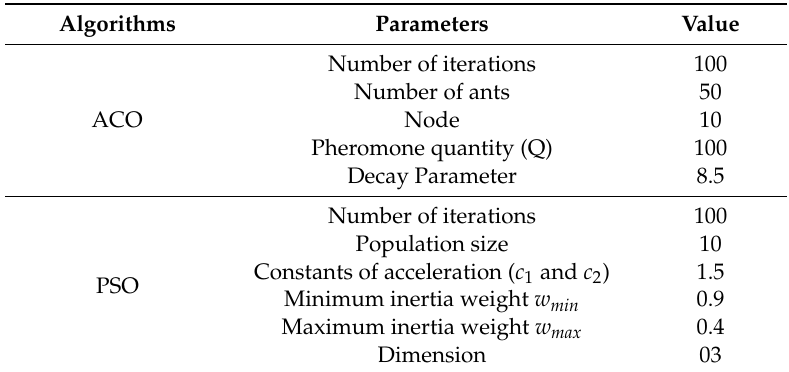
Table 2. Specification of algorithms (ACO and PSO).